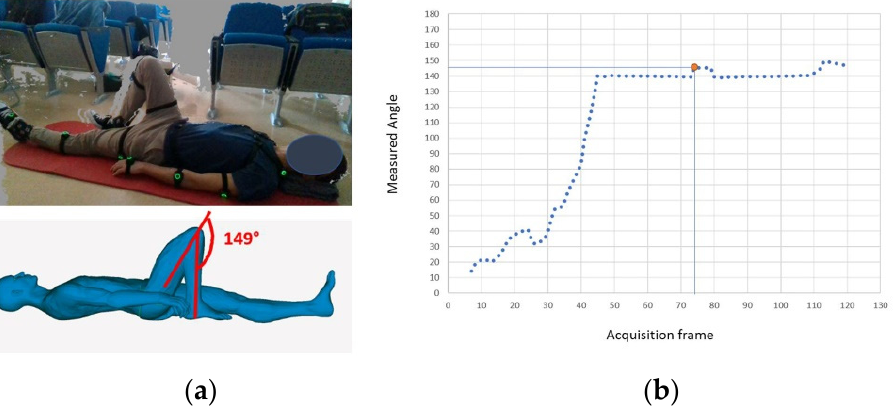
Figure 11. Example of the comparison between the (a) CAD-based measurement on the 3D avatar (ground truth) and the (b) automatic measurement for full contraction of the knee.